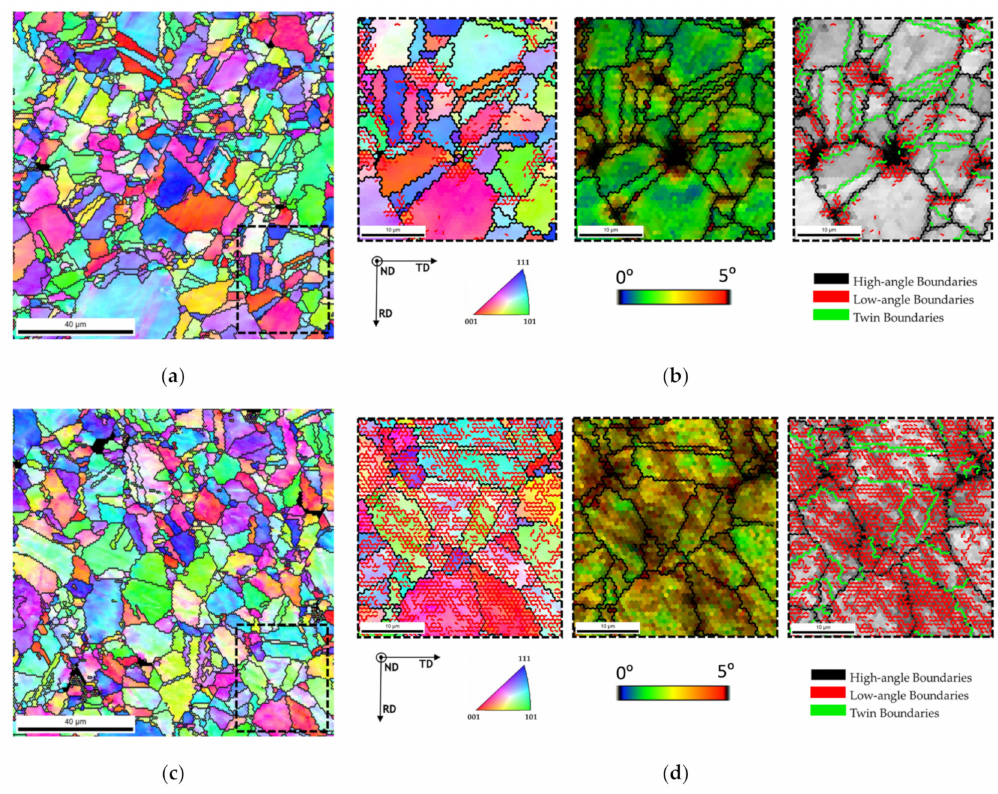
Figure 11. IPF maps of ( a ) Ni and ( c ) Ni-CNT produced by ultrasonication. IPF, KAM, and IQ maps with high- and low-angle boundaries (HAGBs and LAGBs) delimited by the ( b ) area marked in ( a , d ) area marked in ( c ).